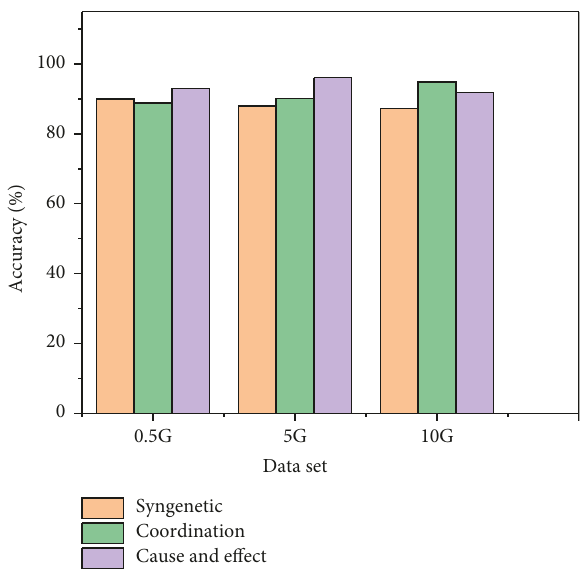
Figure 8: Accuracy of different